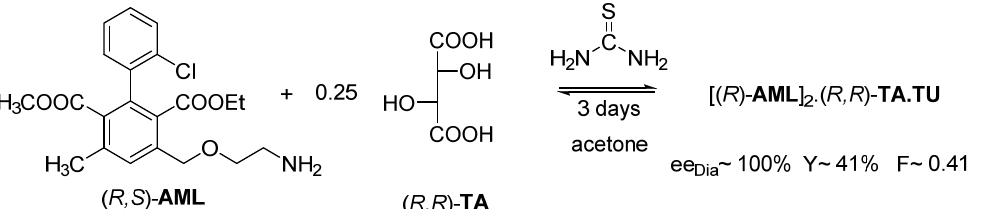
Figure 14. Resolution of racemic Amlodipine with ( R , R )-tartaric acid in acetone with the addition of thiourea. The thermodynamic control takes place in 3 days.